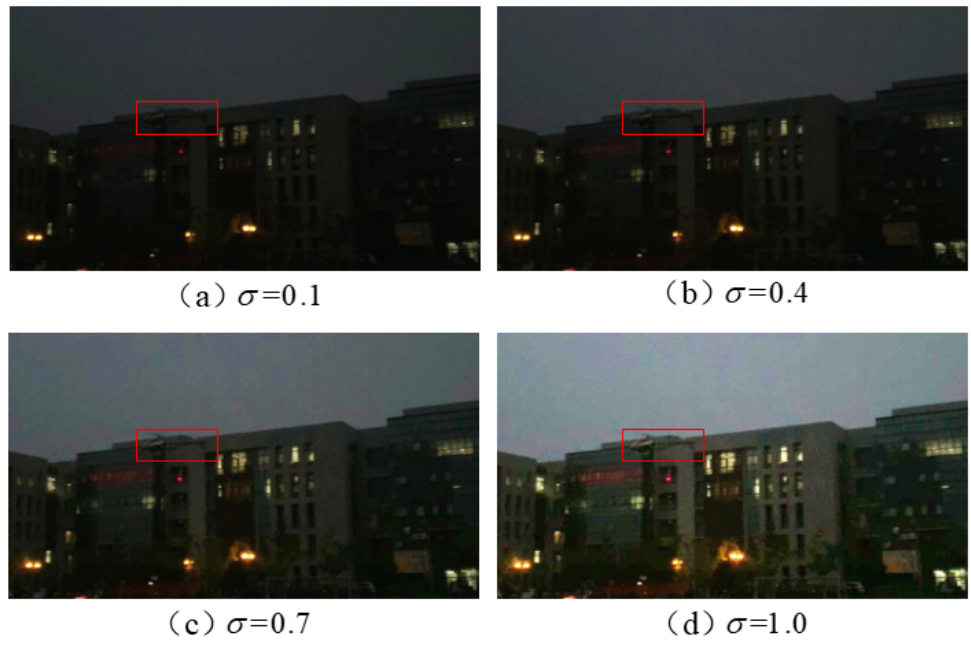
Figure 7. Enhanced results of Video 1 (containing the Align 700L V2 obstacle object) at different σ